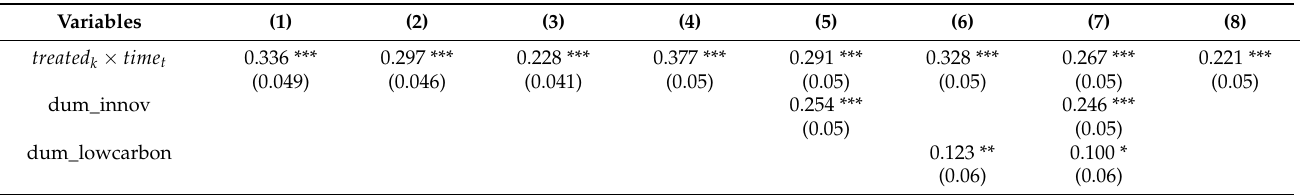
Table 6. Robustness of the test